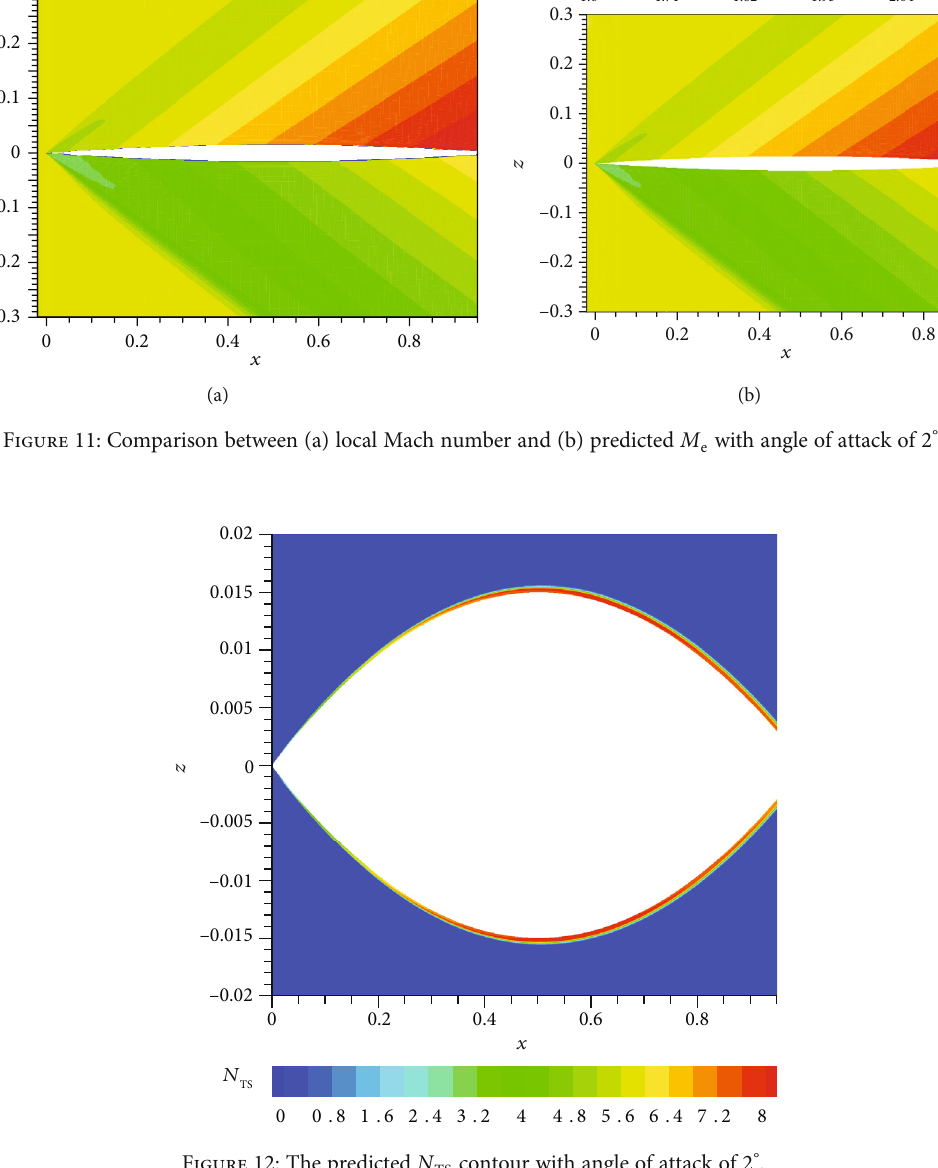
contour with angle of attack of 2 ° . TS